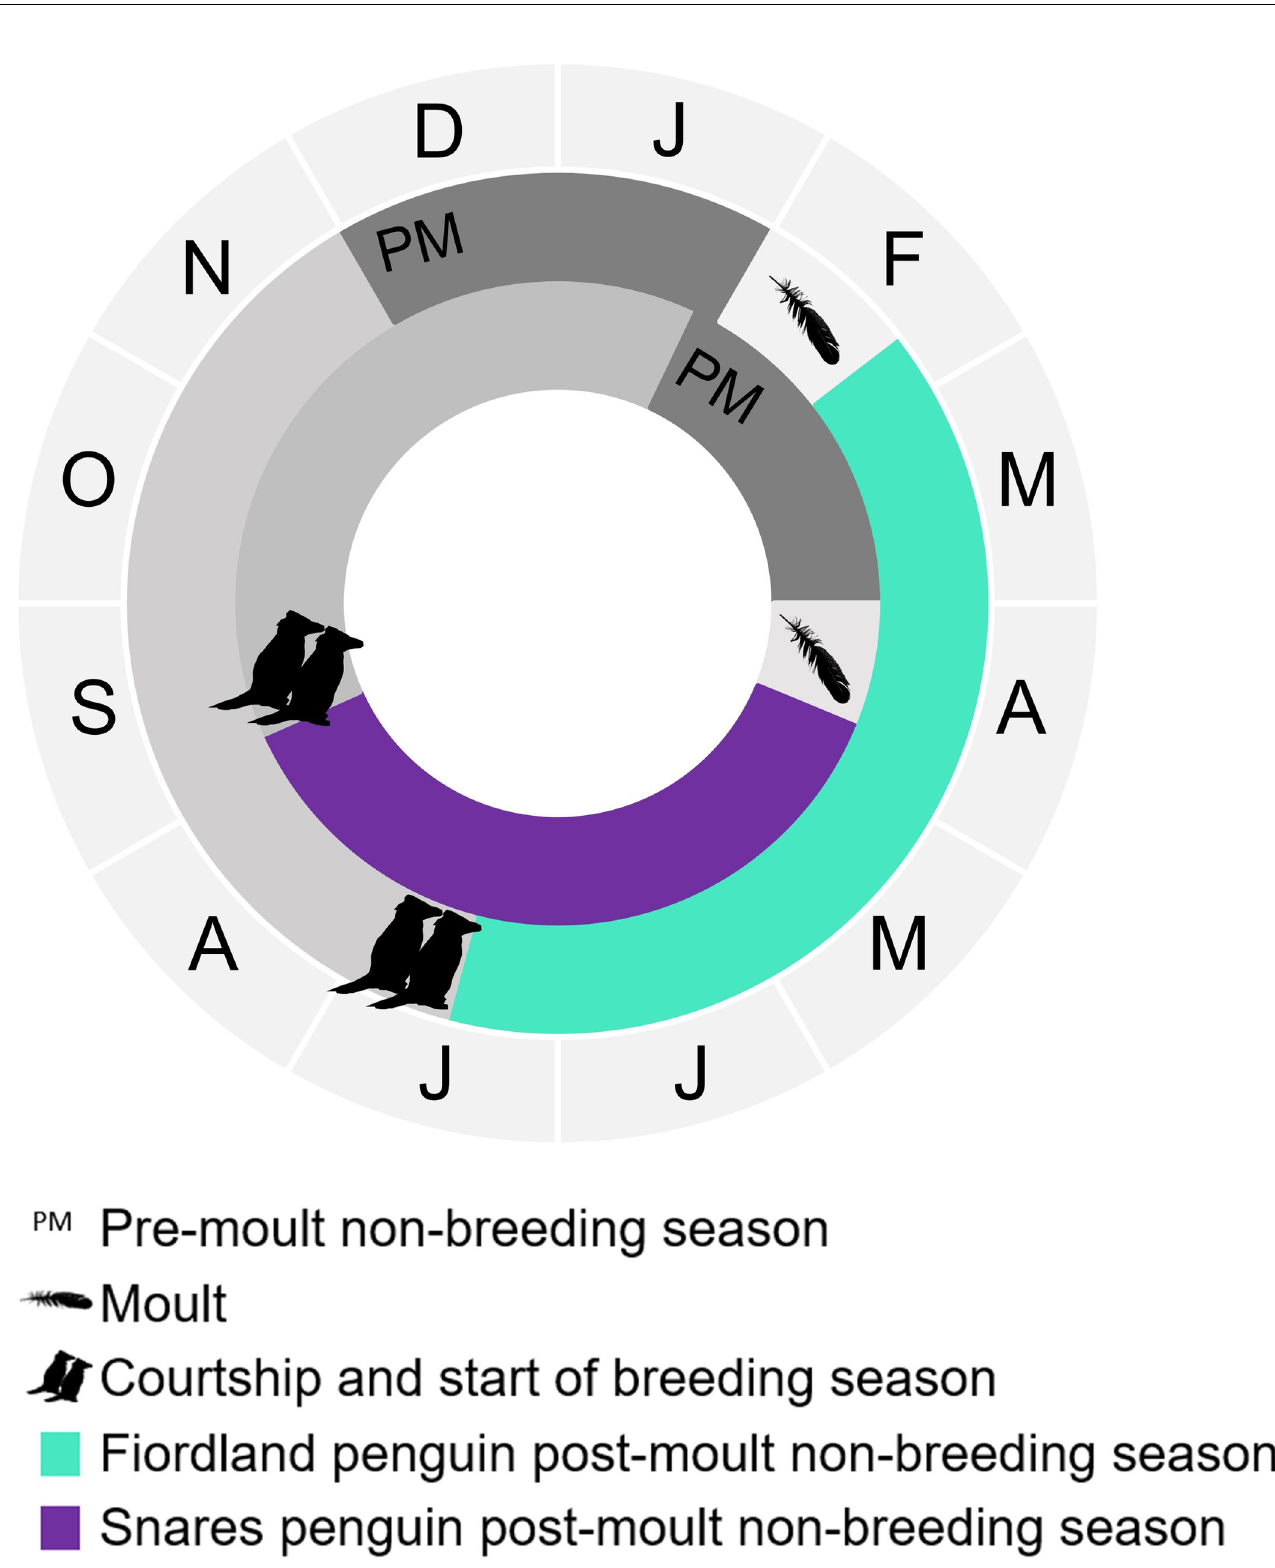
Fig 1. Phenology of Snares penguins and Fiordland penguins, highlighting the post-moult non-breeding seasons. As is typical of Eudyptes species, Snares penguins (purple) begin their non-breeding season at the end of April while Fiordland penguins (turquoise) begin their non-breeding season around 8 weeks before, at the end of